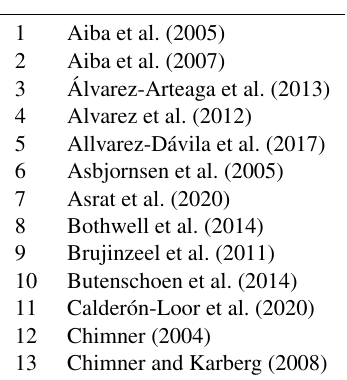
Table B1. List of references selected in the systematic review of the carbon cycle in tropical upland